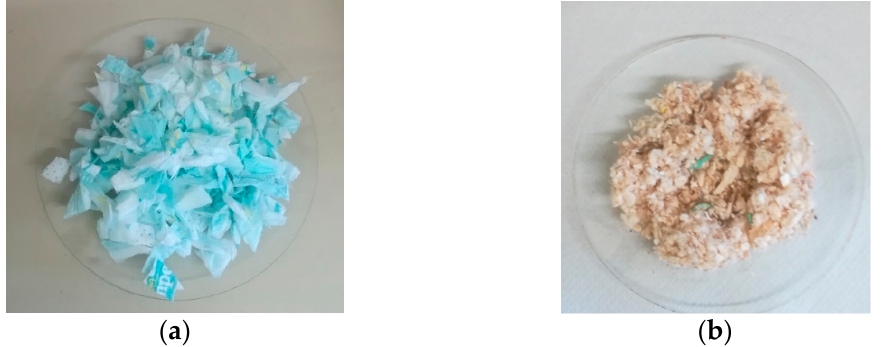
Figure 1. Coarsely shredded diapers (AHPam) ( a ); cellulosic fraction of sterilized diapers (AHPus) ( b